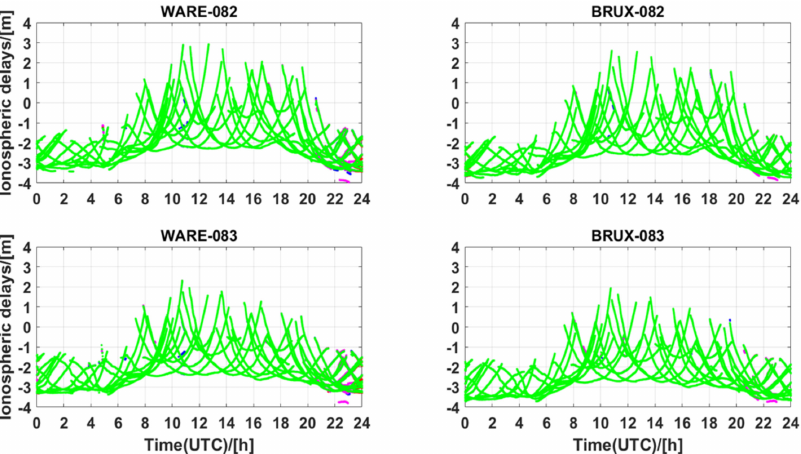
Figure 10. Estimated slant ionospheric delays derived from WARE and BRUX stations on DOY 082, 083, 2021. The four groups of UCPPP PAR solutions—F2-MAX, F2-ALT, F3-MAX, and F3-ALT—are plotted as solid red, blue, pink, and green circles,